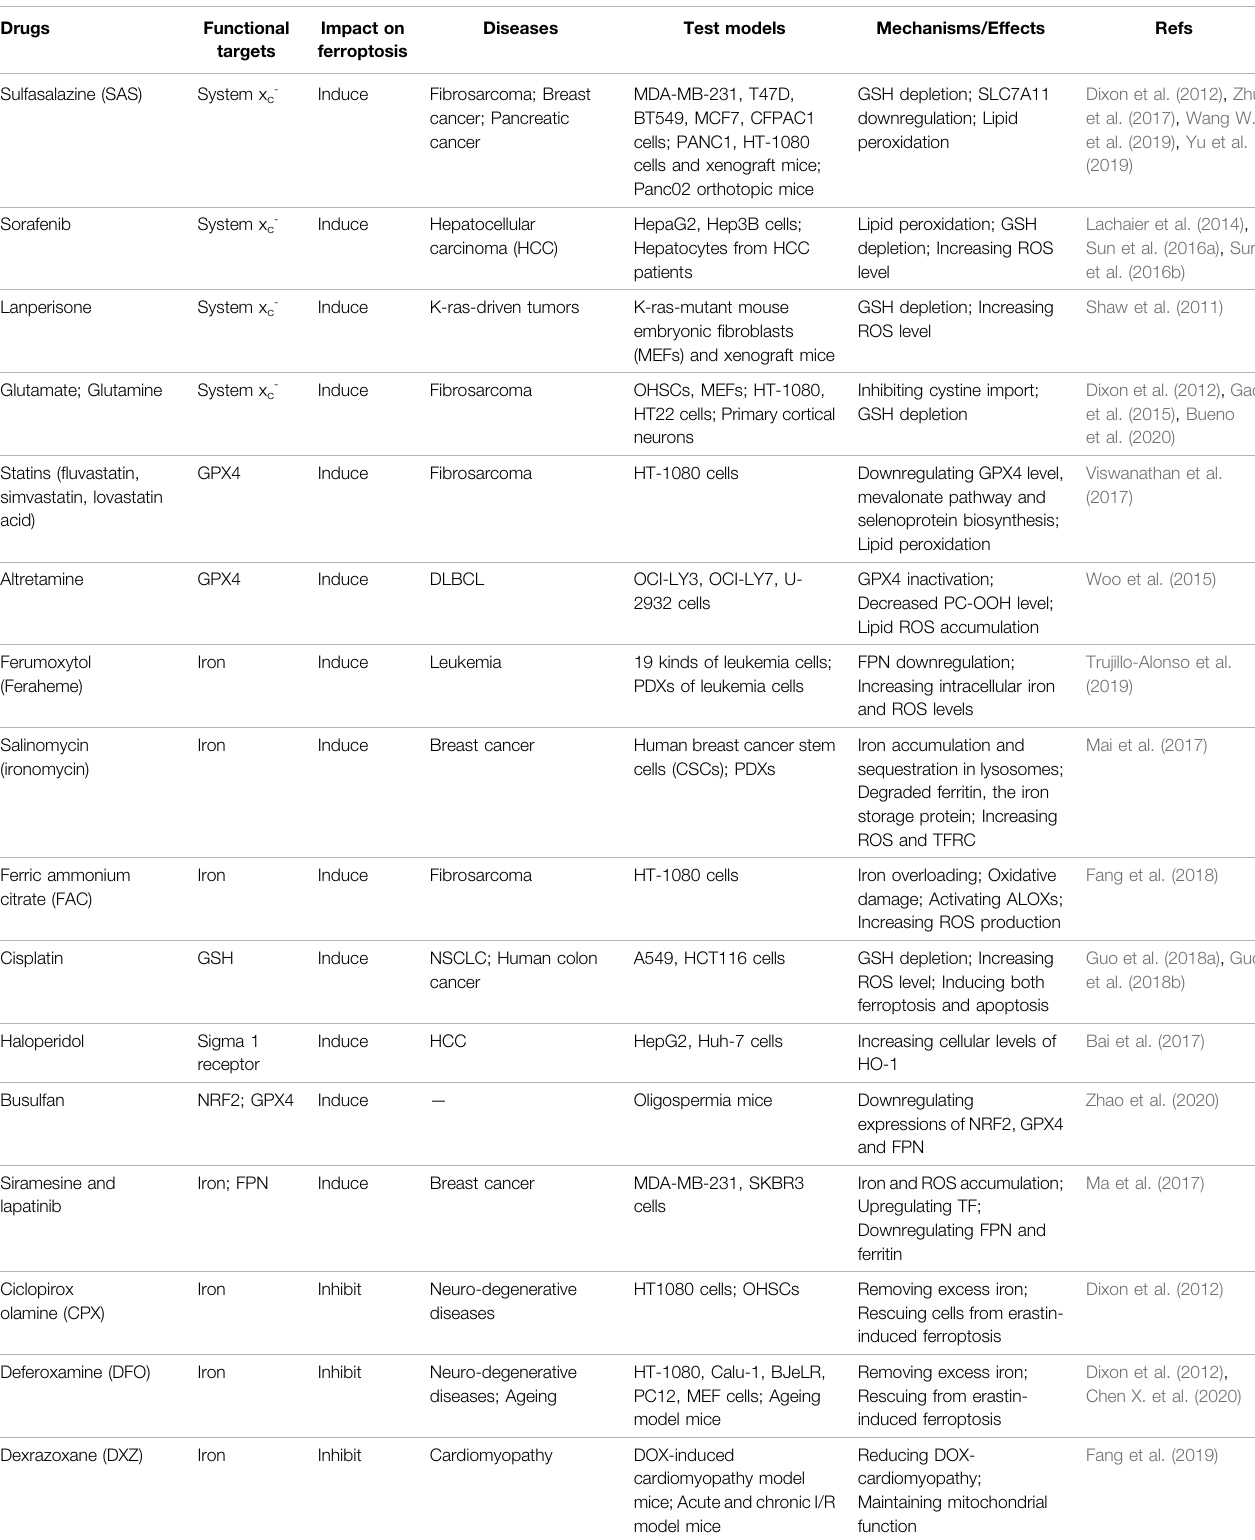
TABLE 2 | FDA-approved synthetic drugs associated with